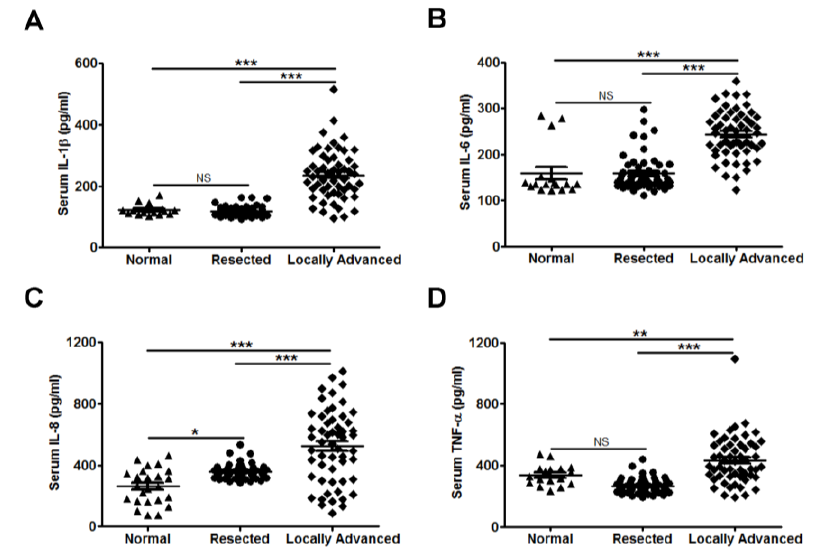
Figure 3. Serum IL-1 β , IL-6, IL-8, and TNF- α levels in healthy donors and PC patients. IL-1 β ( A ), IL-6 ( B ), IL-8 ( C ), and TNF- α ( D ) concentrations were measured by ELISA. Values represent mean ± standard error of the mean; NS, not significant; *, p < 0.05; **, p < 0.01; ***, p < 0.001 compared with the normal group, as determined using one-way analysis of variance (ANOVA).